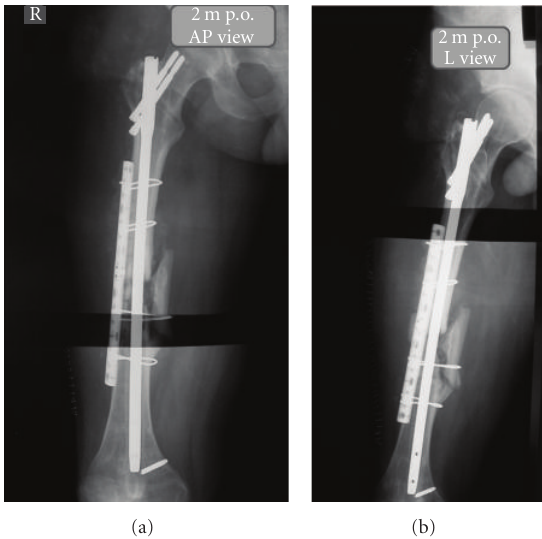
Figure 5: Radiographic imaging of femoral reconstruction two months postoperatively in (a) anteroposterior and (b) lateral view, showing satisfactory callus formation of both the fracture and the osteotomy of the